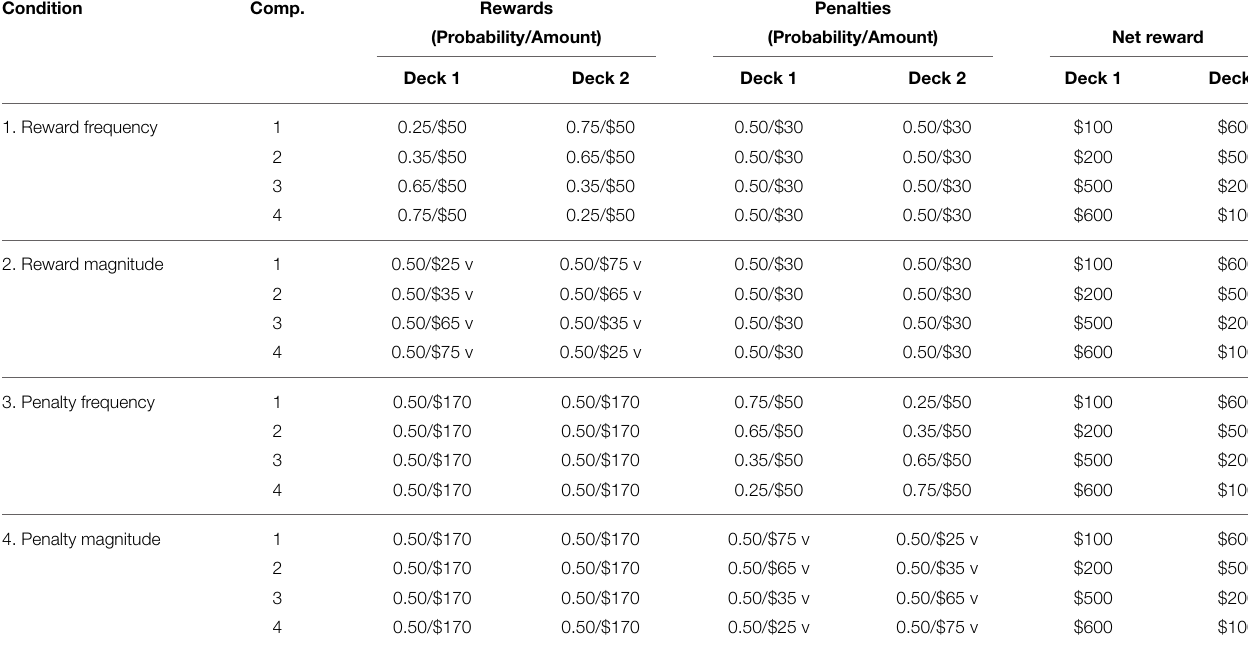
TABLE 4 | Summary of conditions in the Auckland Card Task. Condition